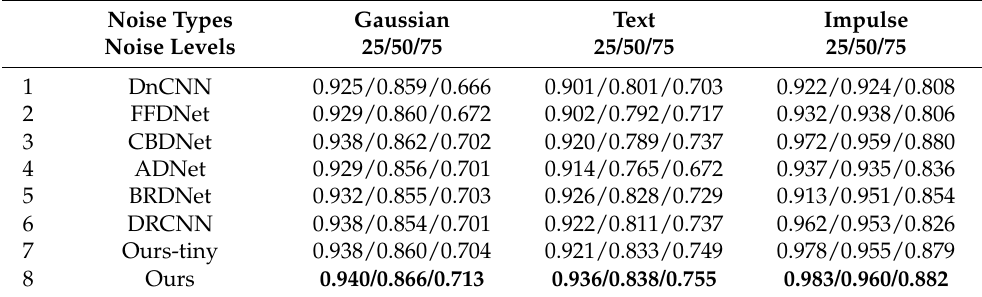
Table 6. Comparison of SSIM metrics of 6 latest CNN-based methods on the Kodak dataset. For each noise type, the highest SSIMs are marked in